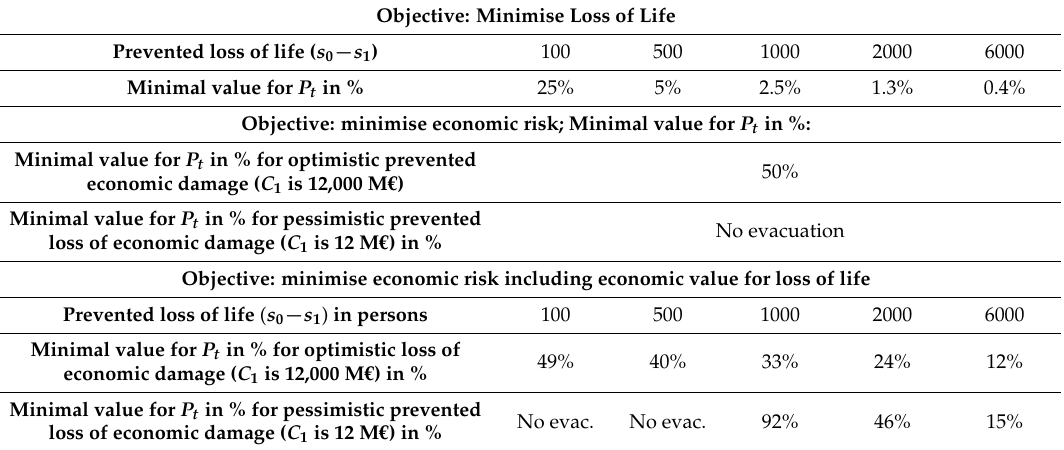
Table 1. Numerical examples for P t to call for